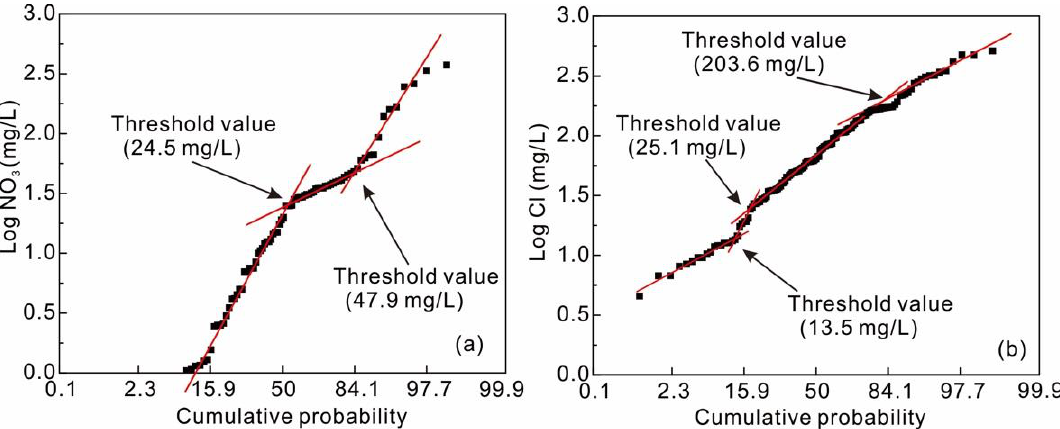
Figure 9. Plots of cumulative probability to determining the threshold values of ( a ) NO 3 − and ( b ) Cl − . Table 3. Results of water type classification.